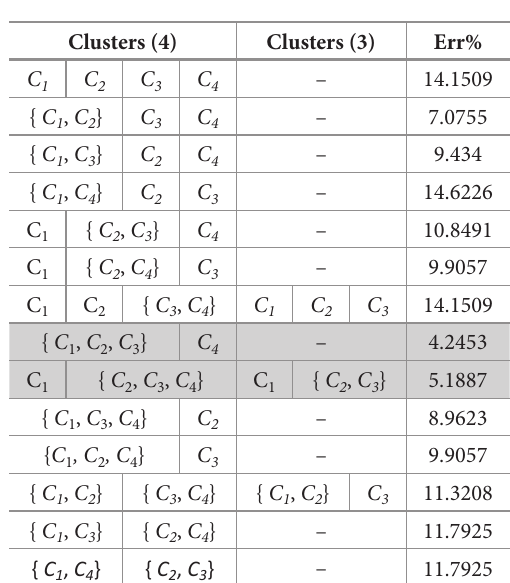
Table 5. Classification errors for each class using C4.5. Best combination lines are shadowed Class B Class